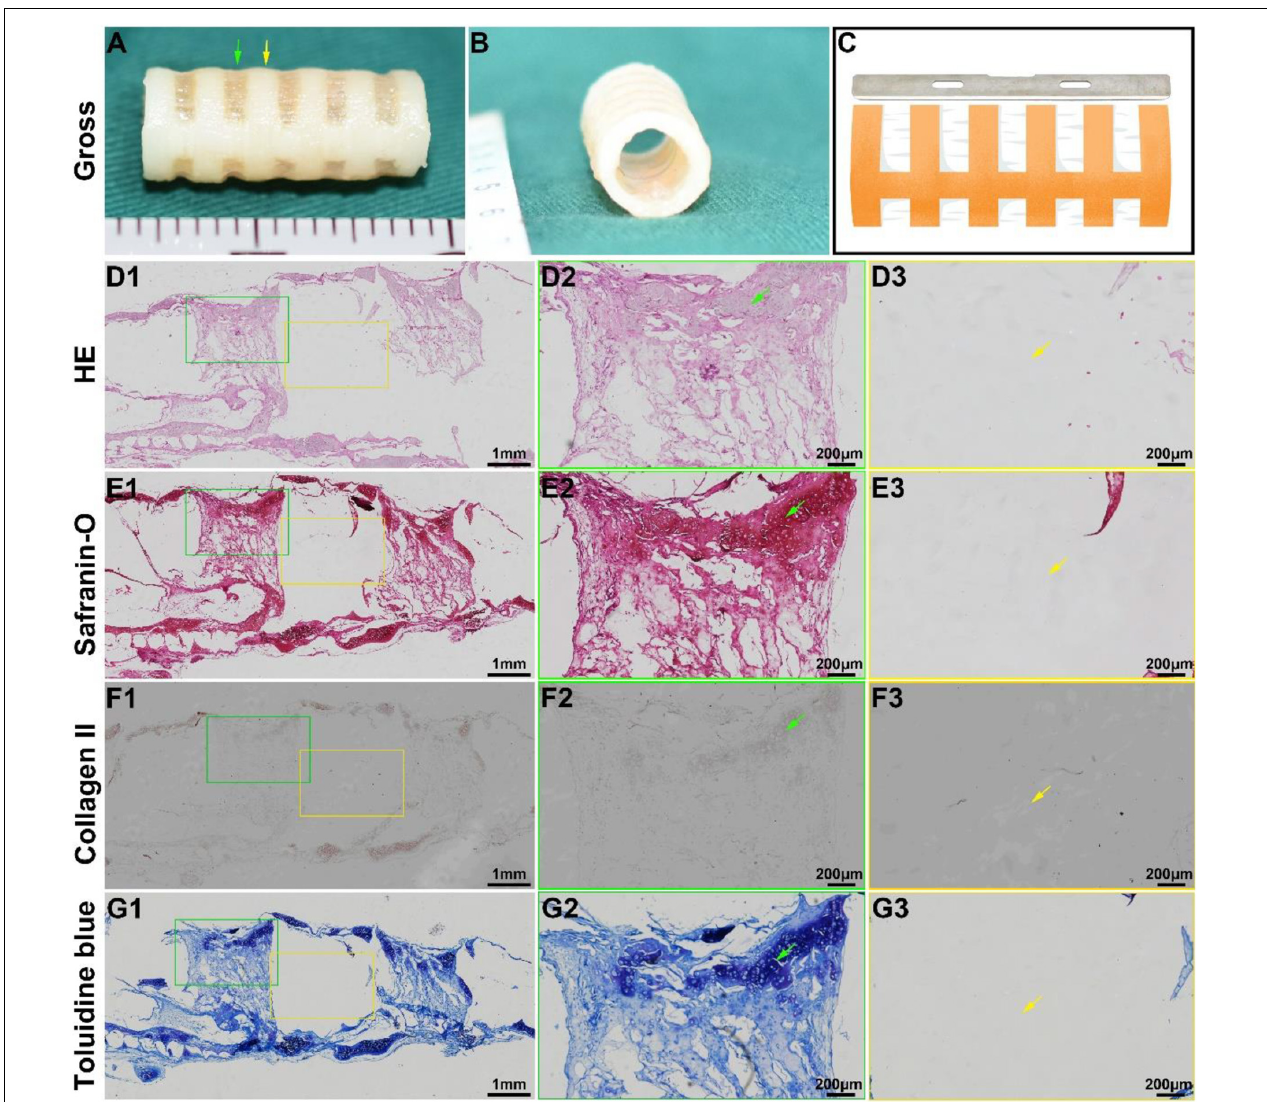
FIGURE 3 | In vitro biomimetic trachea regeneration. Gross view of the biomimetic trachea after 4 weeks in vitro culture (A,B) . (C) shows the sectioning schematic. HE, safranin-O, collagen II, and toluidine blue staining of a longitudinal section of the engineered biomimetic trachea (D1–G1) . Magnified views of a cartilage ring (D2–G2) and PCL ring (D3–G3) . The green arrows indicate cartilage regions, and the yellow arrows indicate PCL regions.